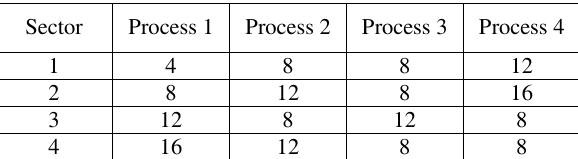
Table 2. Numerical data modified in accordance with Goldratt’s